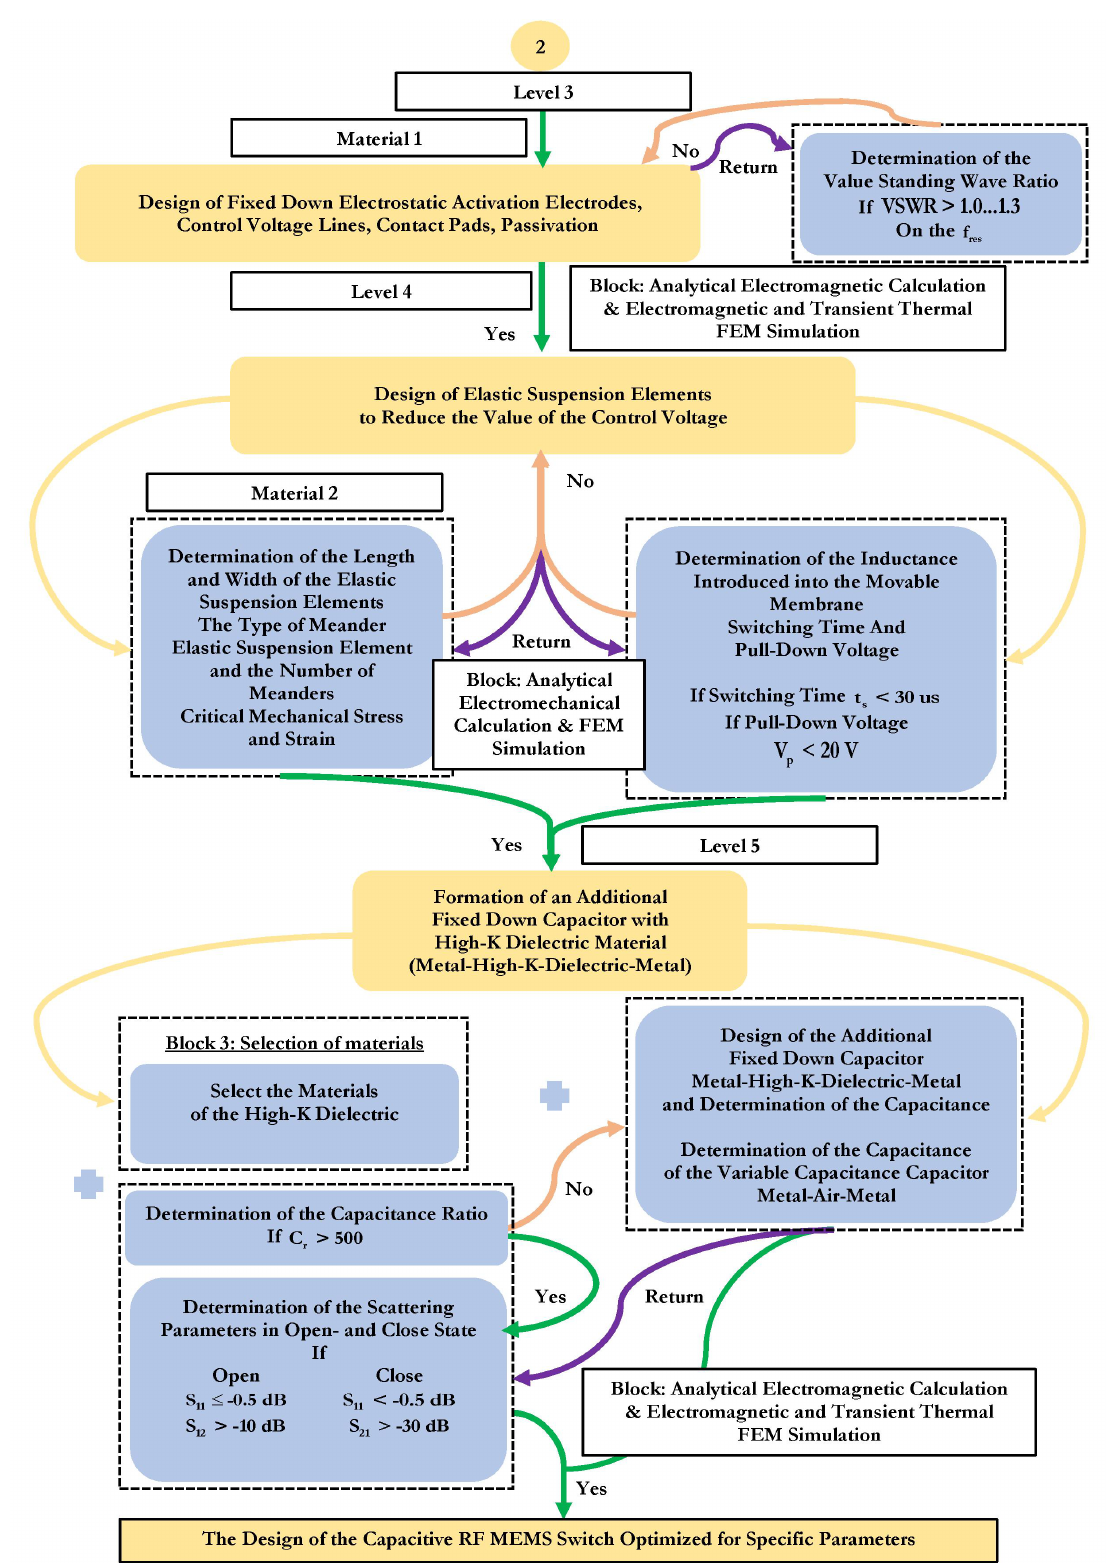
Figure 2. The proposed methodology for optimizing capacitive RF MEMS